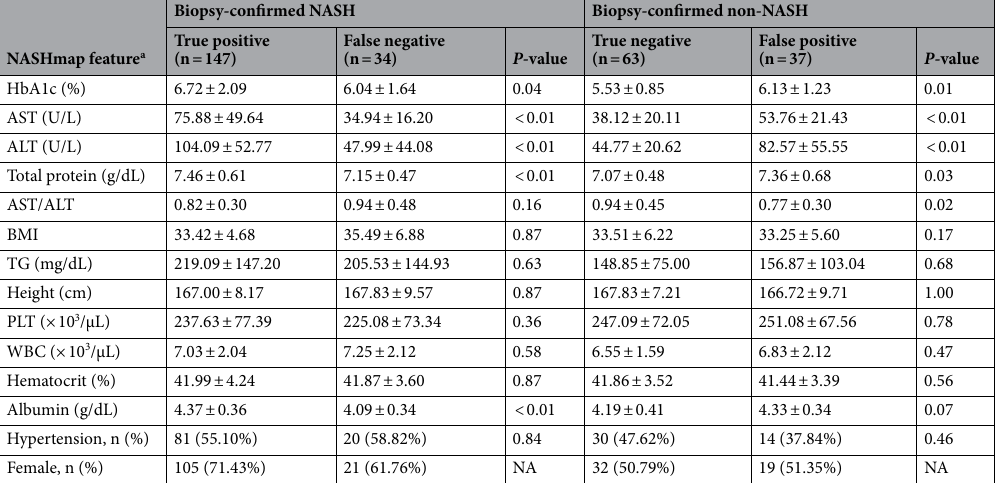
Table 4. Features of patients correctly classified and misclassified by NASHmap in NIDDK. NIDDK: National Institute of Diabetes and Digestive Kidney Diseases; NASH: nonalcoholic steatohepatitis; HbA1c: glycated hemoglobin; AST: aspartate transaminase, ALT: alanine transaminase; BMI: body mass index; TG: triglycerides; PLT: platelets; WBC: white blood cells. a Features are listed by decreasing order of predictive importance in the model. Data are presented as mean ± SD unless otherwise